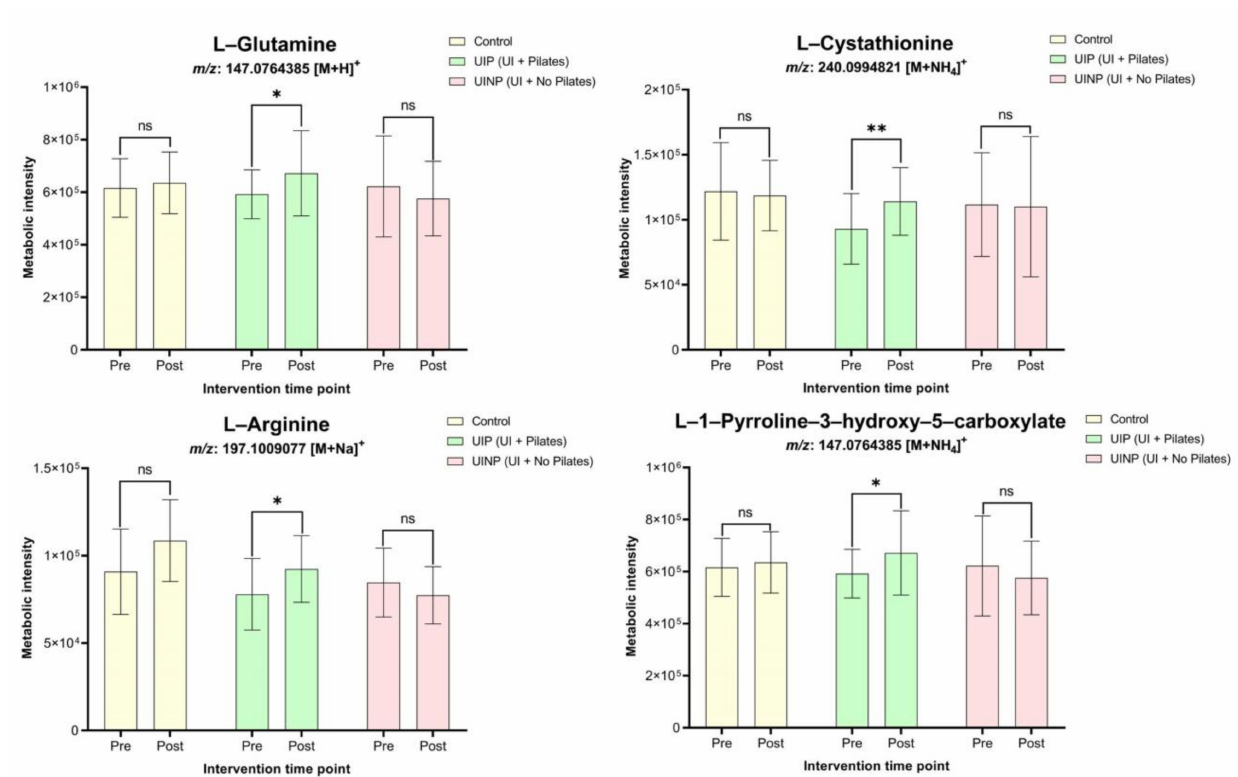
Figure 4. Change in identified metabolic features associated with FMP ratio between pre- and post-intervention in Control, UIP, and UINP. Control: control group; UIP: urinary incontinence group with Pilates; UINP: urinary incontinence group with no Pilates; m / z : mass-to-charge ratio in ions that quantifies molecules in chemical or biological mixture. Pre: before 8-weeks intervention; post: after 8-weeks intervention. * ( p < 0.05): significantly different from Pre. ** ( p < 0.001): significantly different from Pre. ns means